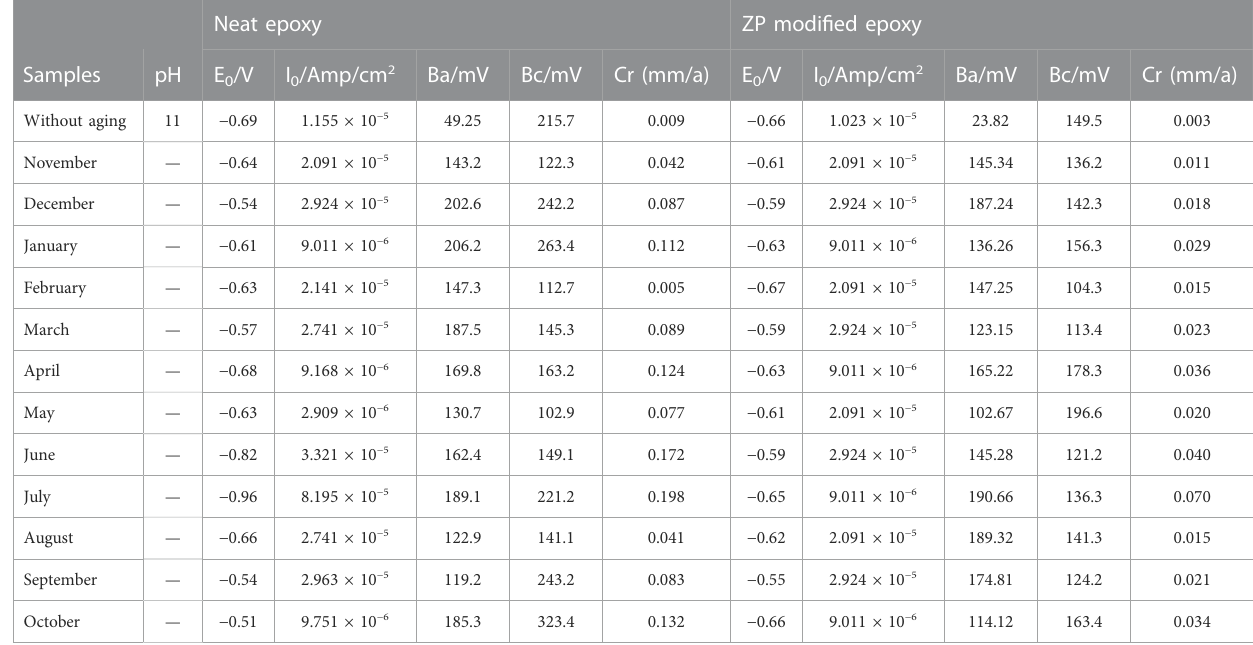
TABLE 4 Electrochemical measurements for ZP modi fi ed and neat epoxy coating on Al alloy 6101 samples in corrosion solution. Neat epoxy Samples Without